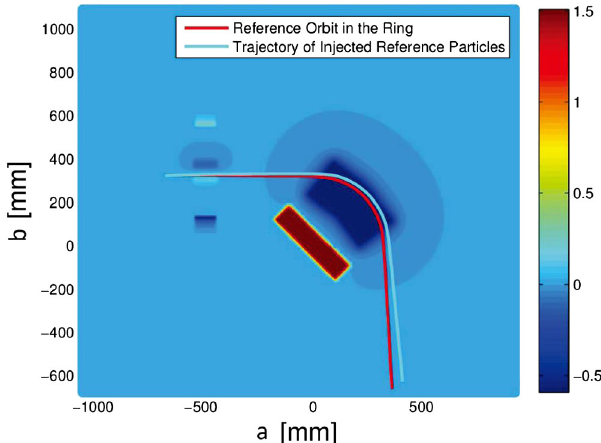
FIG. 10. Injection trajectory in the central ( x; s ) plane at z ¼ 0 . The Cartesian coordinates ð a; b Þ in the central plane are used to present the simulated magnetic field. The injection trajectory and the reference orbit are respectively shown in cyan and red curves. The color bar means the value of magnetic field B particles move from right to the left, passing through the fringe field region of the dipole magnet and the quadrupole. The left end of the two trajectory is the entry of the kicker which corresponds to the point B shown in Fig. 9. The optimum x 4.9 mm and 28 mrad,